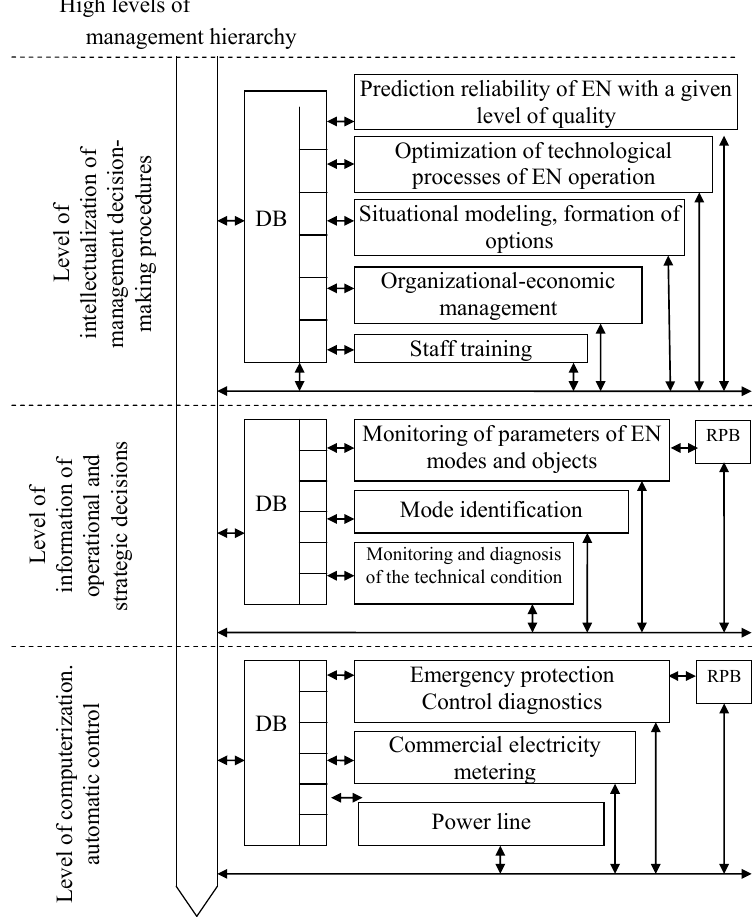
Fig. 1. Architecture of an intellectual traction electric network of transport